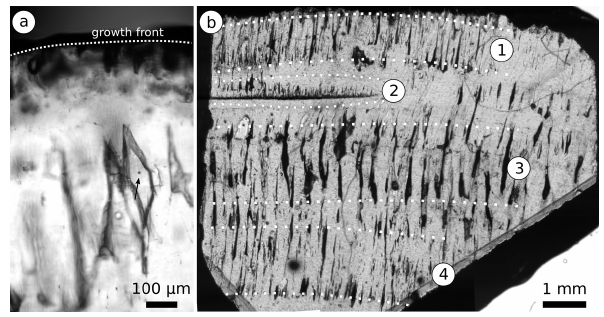
Figure 2. (a) Top of stalagmite M1 with the (active) growth front marked by the dotted line. The photograph was taken after the gen- eration of the vapour bubble marked by the arrow. (b) Photograph of the thin section of the top of stalagmite M2. The dotted lines in- dicate the growth bands 1–4 with the fluid inclusion assemblages, with 1 being the